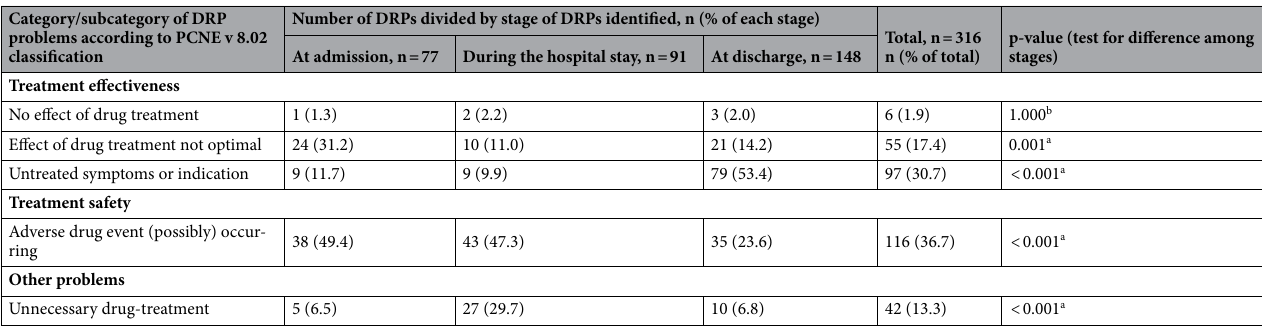
Table 1. Problems of drug-related problems identified among three stages of hospital stay. DRP drug-related problem, PCNE Pharmaceutical Care Network Europe. a p-value of Chi-square for comparing three groups,